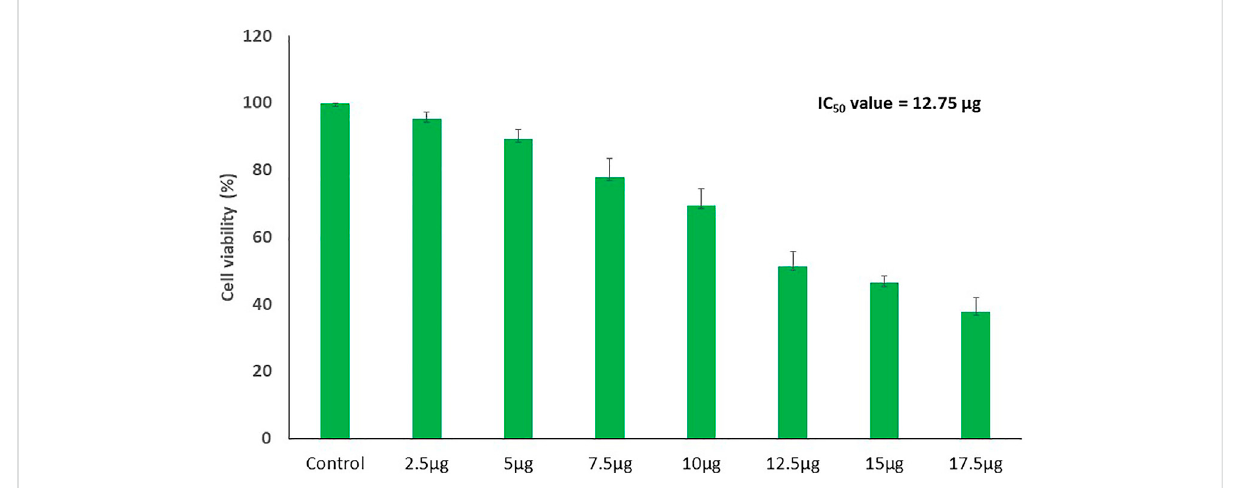
FIGURE 7 Dose-dependent decline in the cell viability of PA-1 cells after treating with variable concentrations of MgONPs.